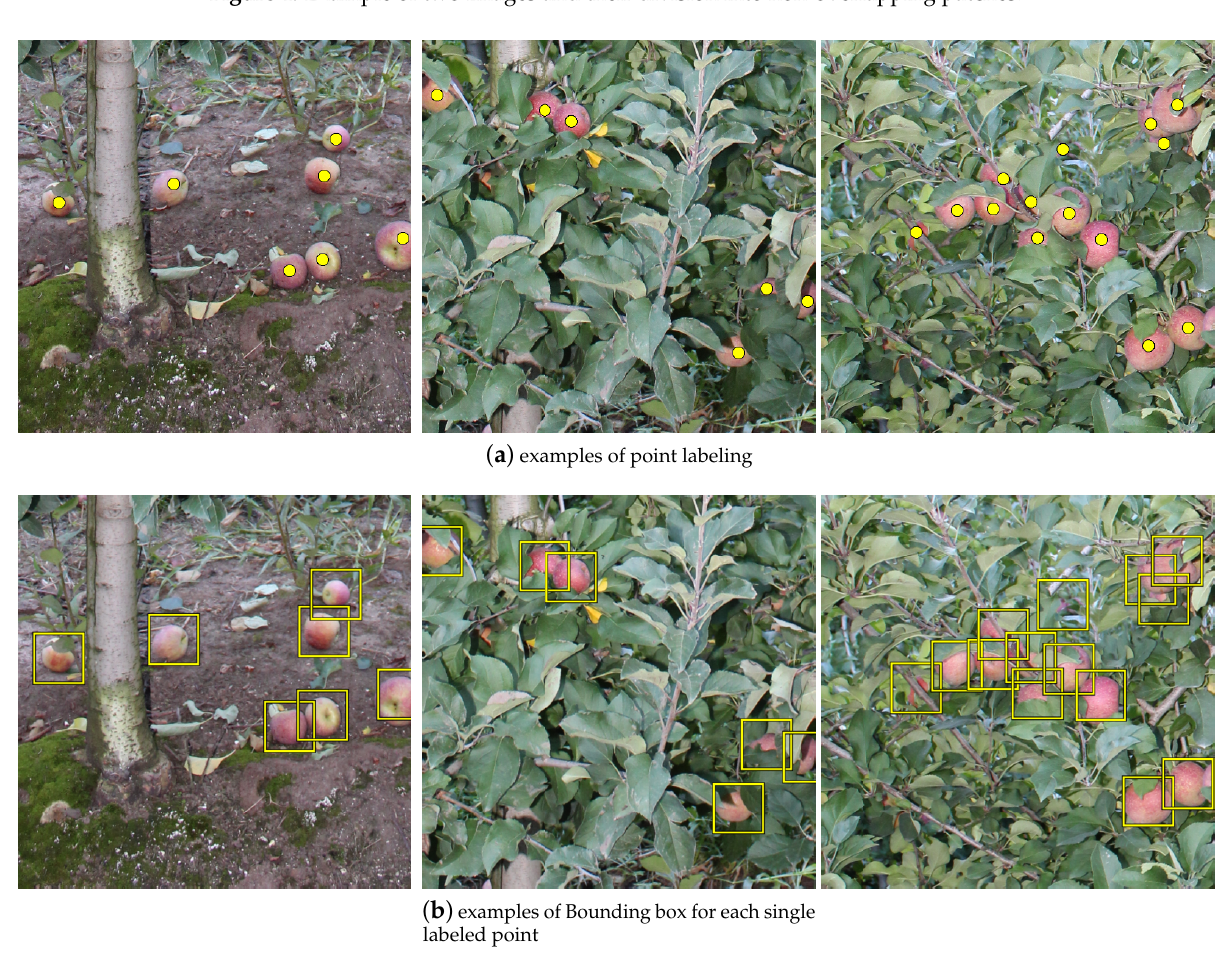
Figure 5. Subsets of a given RGB image showing some examples of manual labeling with points in the center of the apple fruits ( a ) and estimation of bounding box with fixed size for each single labeled point ( b